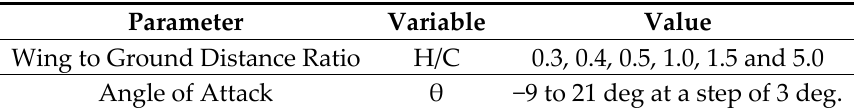
Table 1. Test variables of the experiment.